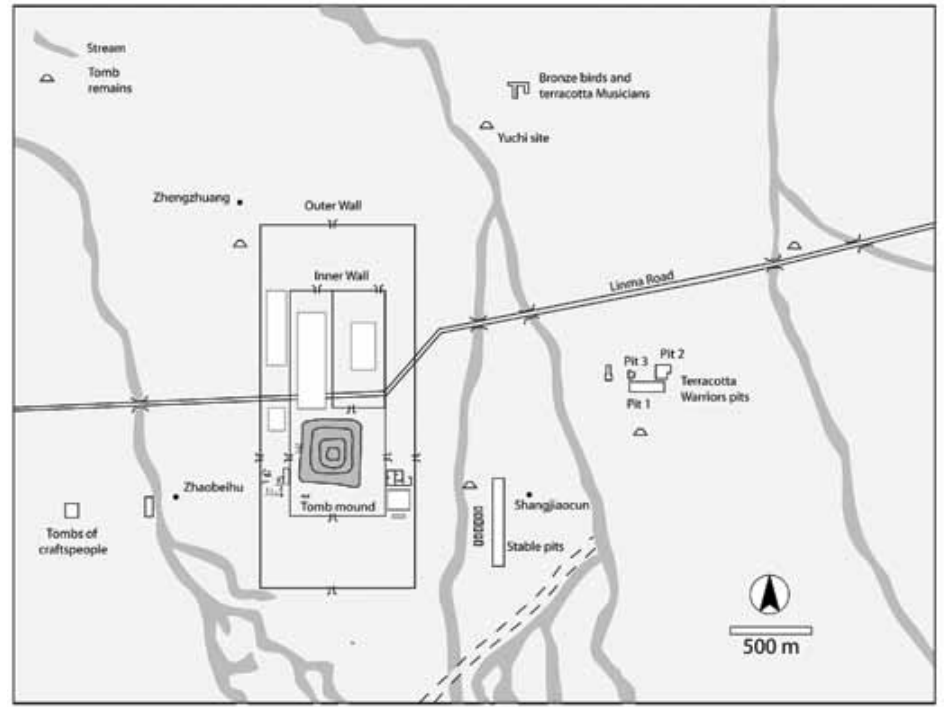
Fig. 1: Site plan of the First Emperor’s Mausoleum, showing the location of the Emperor’s Tomb towards the centre, the Terracotta Army to the east, and other elements of the